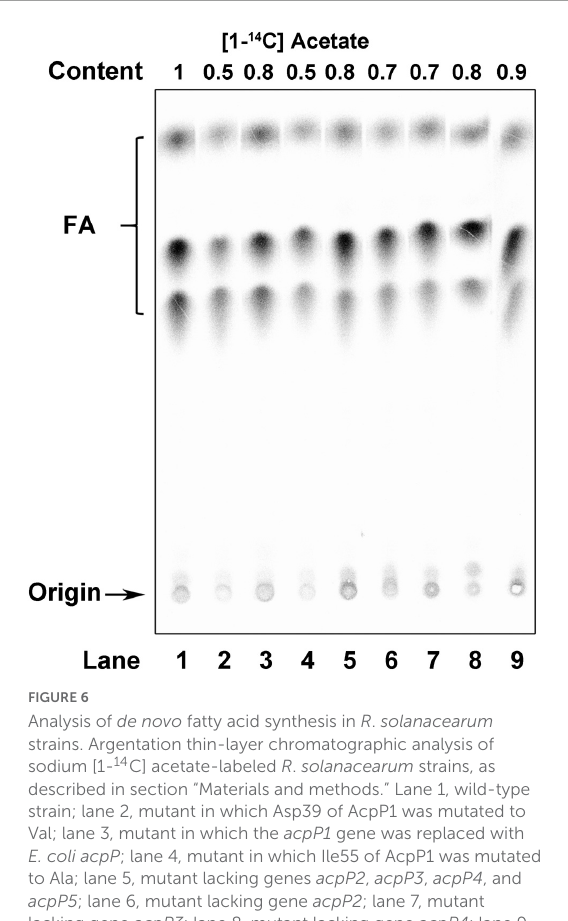
FIGURE6 Analysis of de novo fatty acid synthesis in R . solanacearum strains. Argentation thin-layer chromatographic analysis of sodium [1- 14 C] acetate-labeled R . solanacearum strains, as described in section “Materials and methods.” Lane 1, wild-type strain; lane 2, mutant in which Asp39 of AcpP1 was mutated to Val; lane 3, mutant in which the acpP1 gene was replaced with E. coli acpP ; lane 4, mutant in which Ile55 of AcpP1 was mutated to Ala; lane 5, mutant lacking genes acpP2 , acpP3 , acpP4 , and acpP5 ; lane 6, mutant lacking gene acpP2 ; lane 7, mutant lacking gene acpP3 ; lane 8, mutant lacking gene acpP4 ; lane 9, mutant lacking gene acpP5 . The numbers above the lanes give the relative incorporation value for each lane.